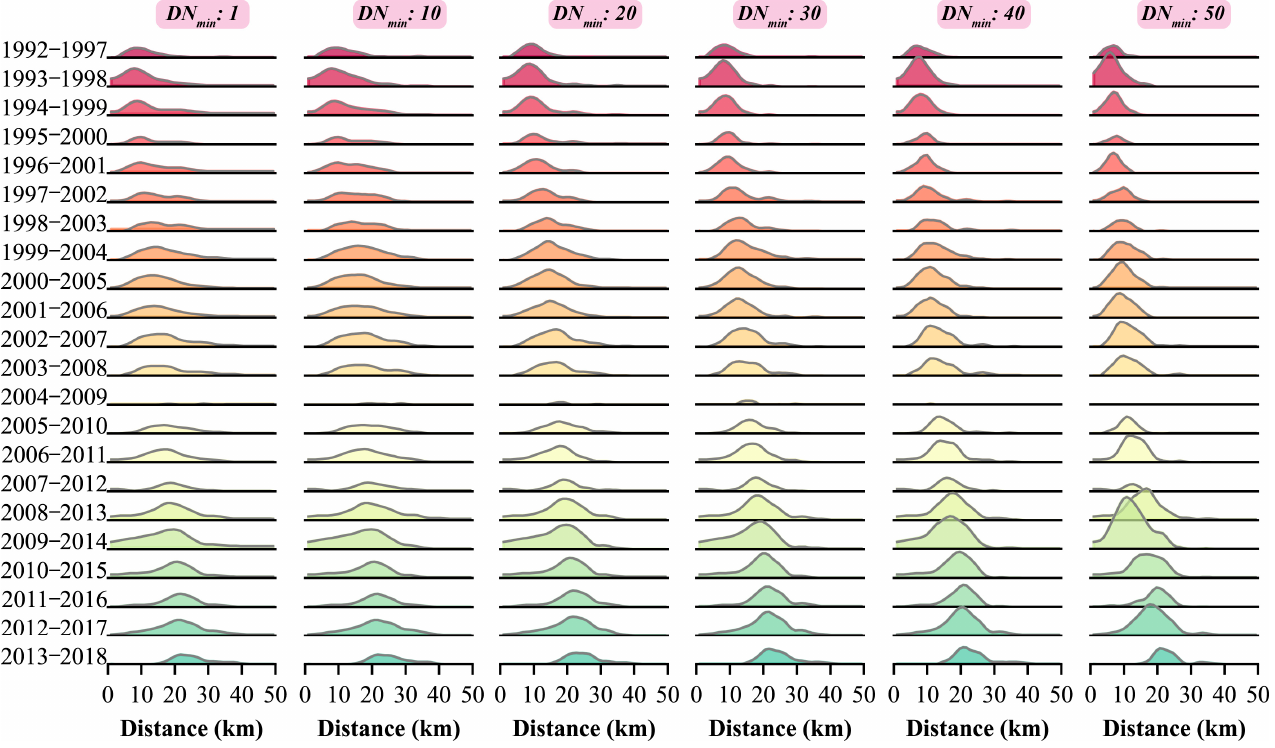
Figure 6. Wave of spatiotemporal variations in different levels of human activities in Wuhan from 1992 to 2018 when the time intervals are fixed as 5 years and the DN min parameter varies from 1 to 50 (the lower and upper limit of the y -axis in subplots is 0 and 1, respectively).